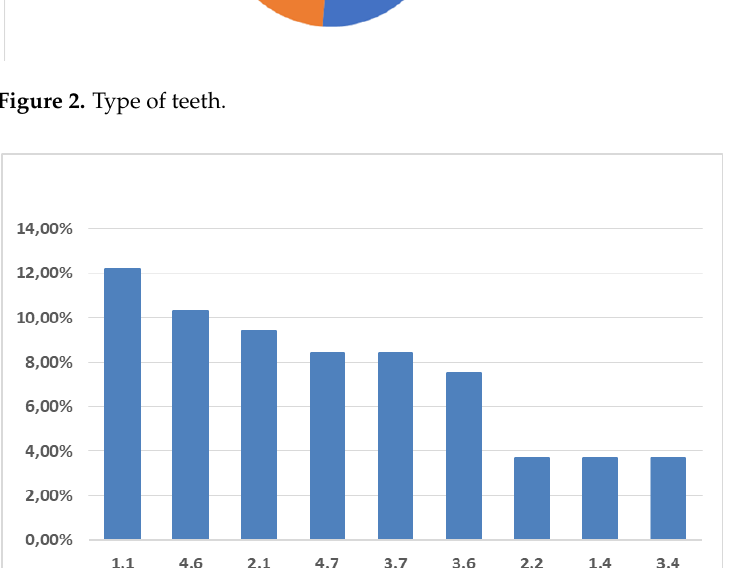
Figure 3. Percentages of treated teeth. Extra-alveolar time stay was reported in 72 of 106 cases, corresponding to an average of 13.01 min. No data on the management of extra-alveolar environmental conditions and